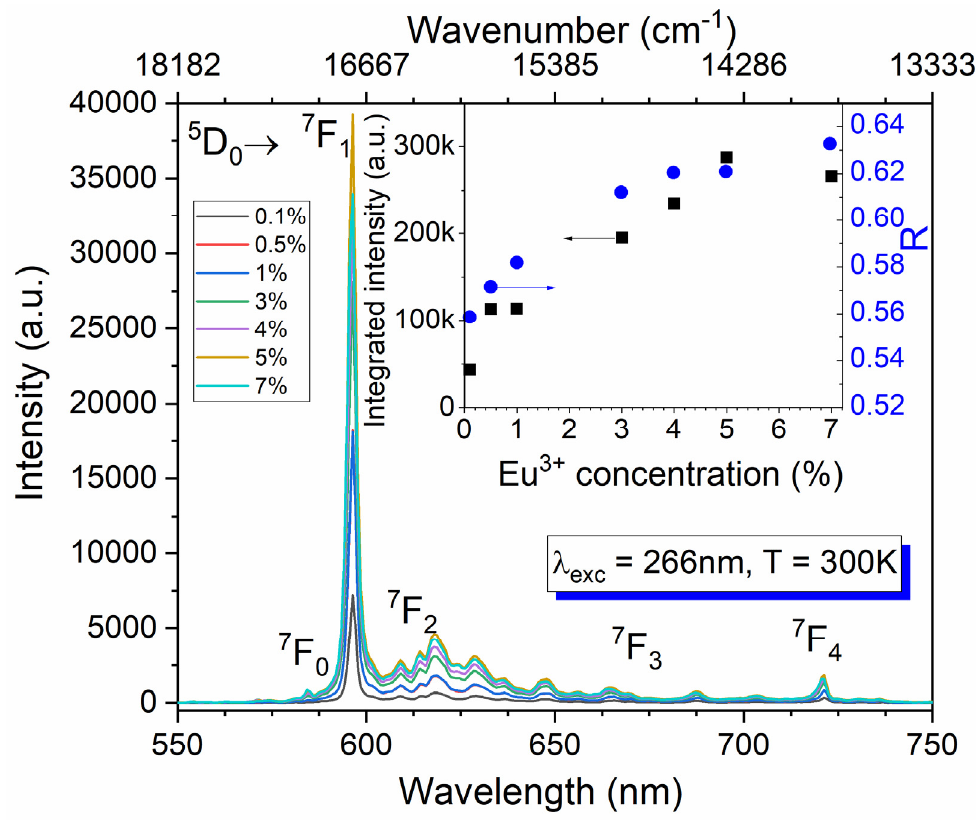
Figure 4. The 300 K emission spectra of Ba 2 MgWO 6 : x% Eu 3 + , (x = 0.1, 0.5, 1, 3, 4, 5, 7%) recorded under 266 nm excitation Nd: YAG line. Inset: the integrated emission intensity and the R parameter (see text for explanation) in function of Eu 3 + concentration.